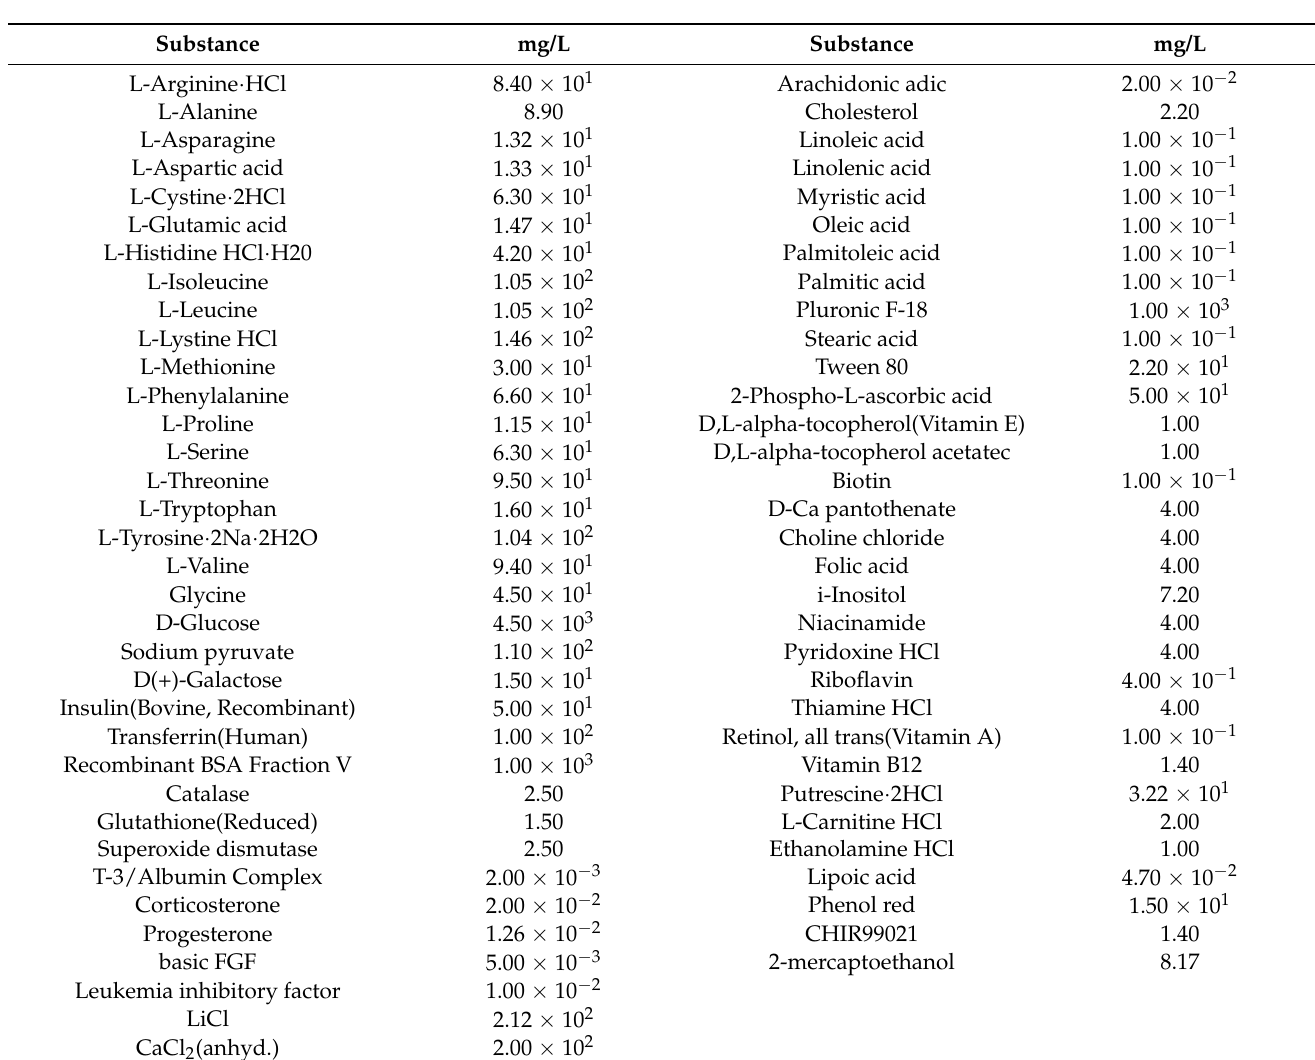
Table 4. Components of the iCD1